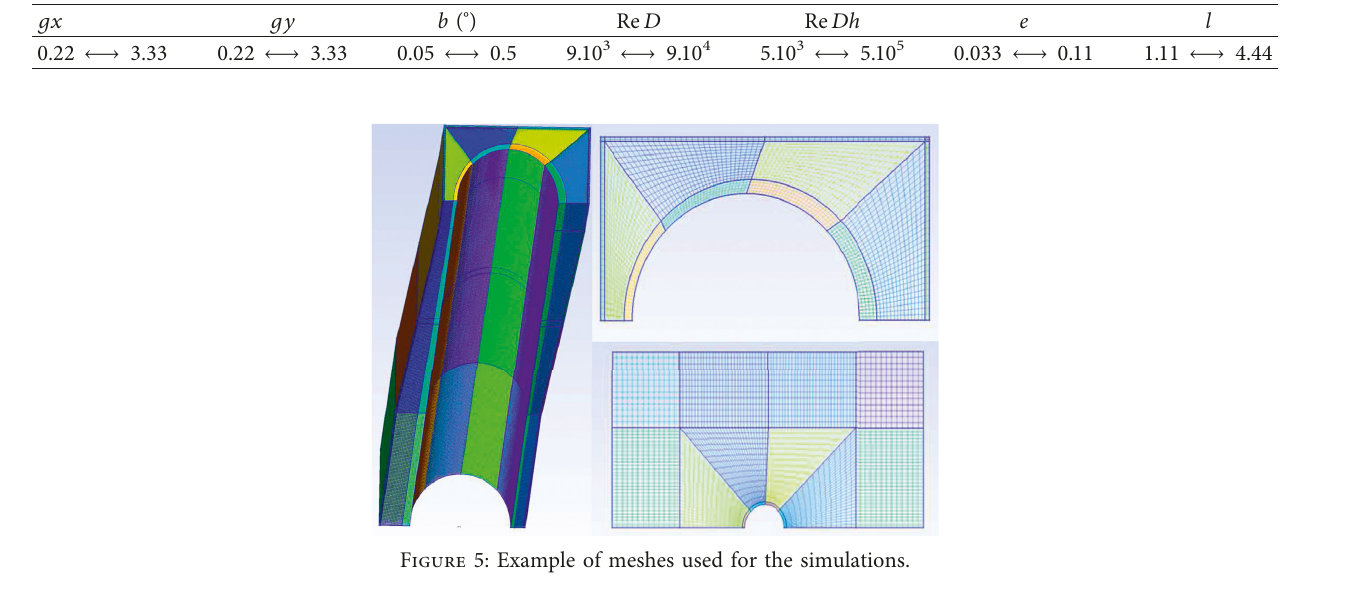
Table 2: Parameter range used for the simulations.